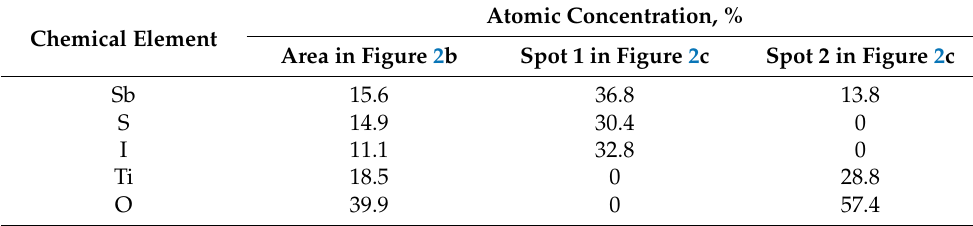
Table 1. The chemical composition determined for the areas of the sample shown in Figure 2b,c.